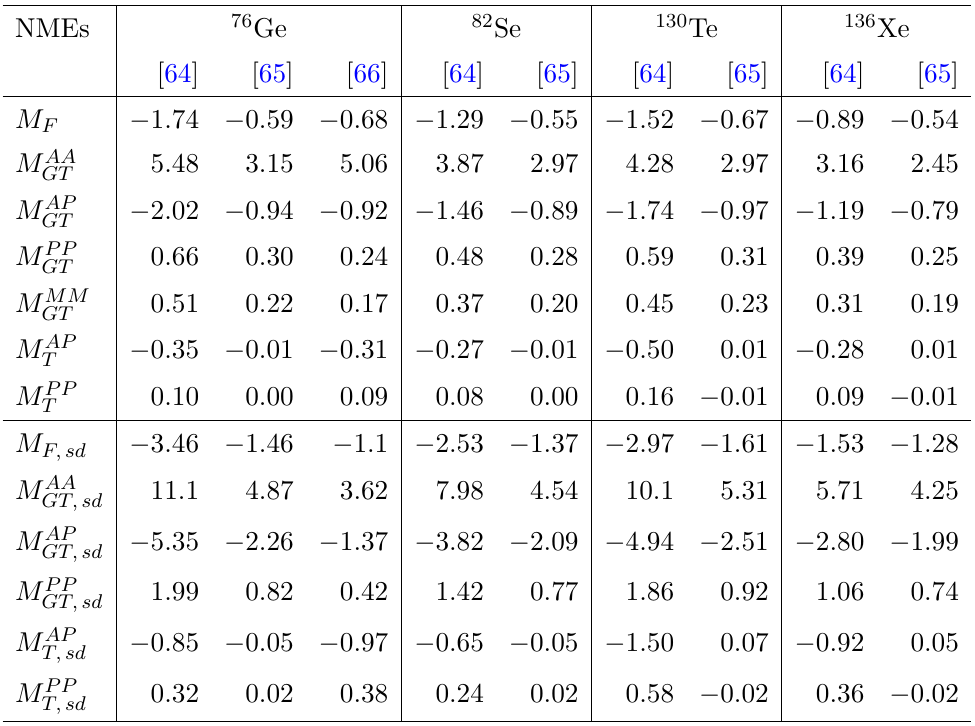
Table 2. Nuclear matrix elements as obtained in the quasi-particle random phase approximation (QPRA) [64], shell model [65], and interacting boson model (IBM) [66] for different isotopes.